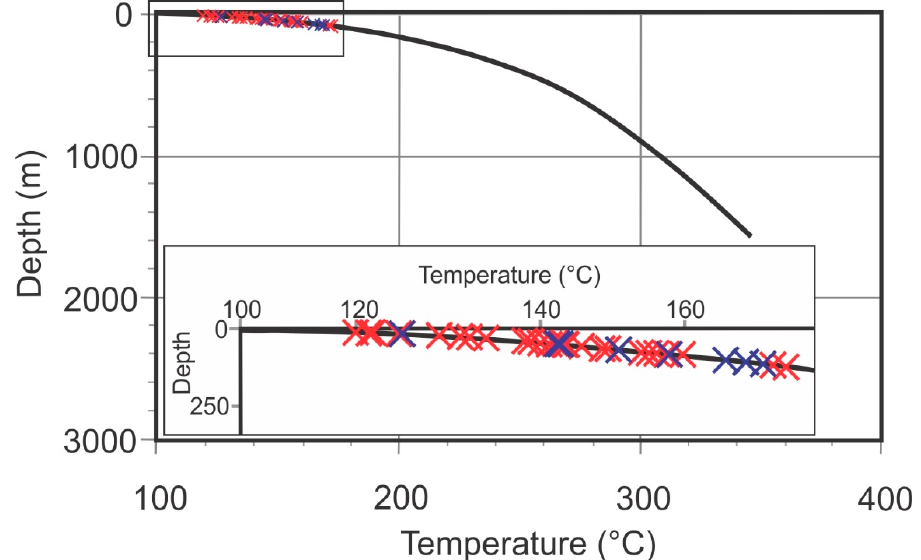
Figure 7. Temperature versus water depth boiling curve for seawater. Fluid inclusion homogenization temperatures (Table 2) superimposed on the seawater boiling curve data from Reference [17]. The expanded inset shows that homogenization temperatures are consistent with boiling seawater at depths ranging approximately between 15 and 125 m. Red and blue crosses represent the secondary and pseudosecondary fluid inclusions, respectively.